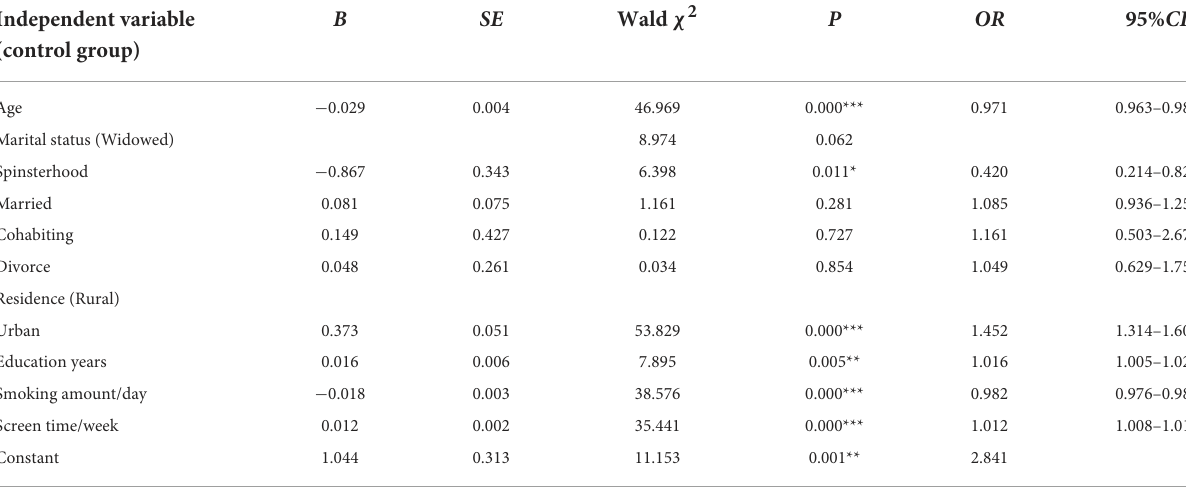
TABLE 2 Binary logistic regression analysis results of factors affected of BMI in older adults in China. Independent variable